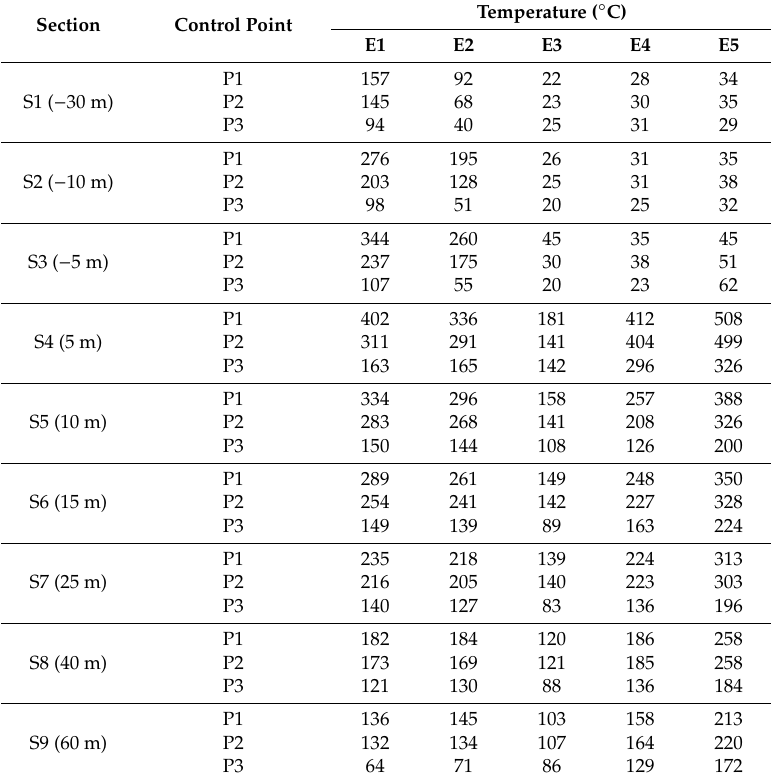
Table 6. FDS values for the same